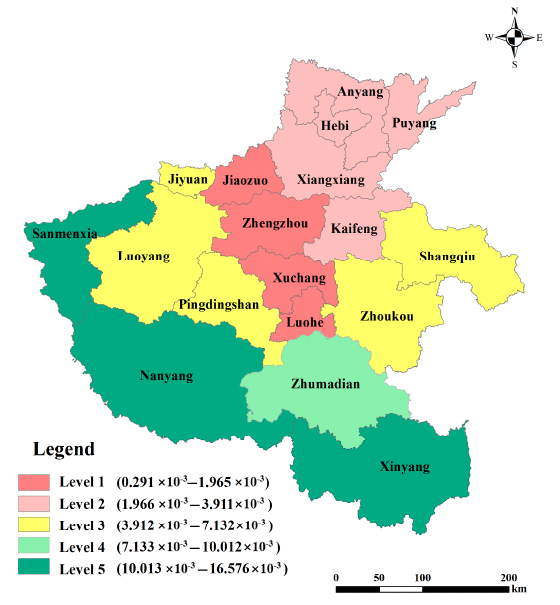
Figure 5. Carbon compensation priority sequence at the prefecture-level city scale.